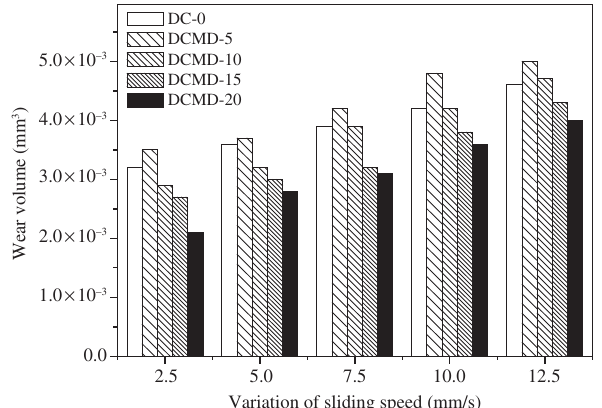
Figure 7: Effect of sliding speed on wear volume of the marble dust-filled dental